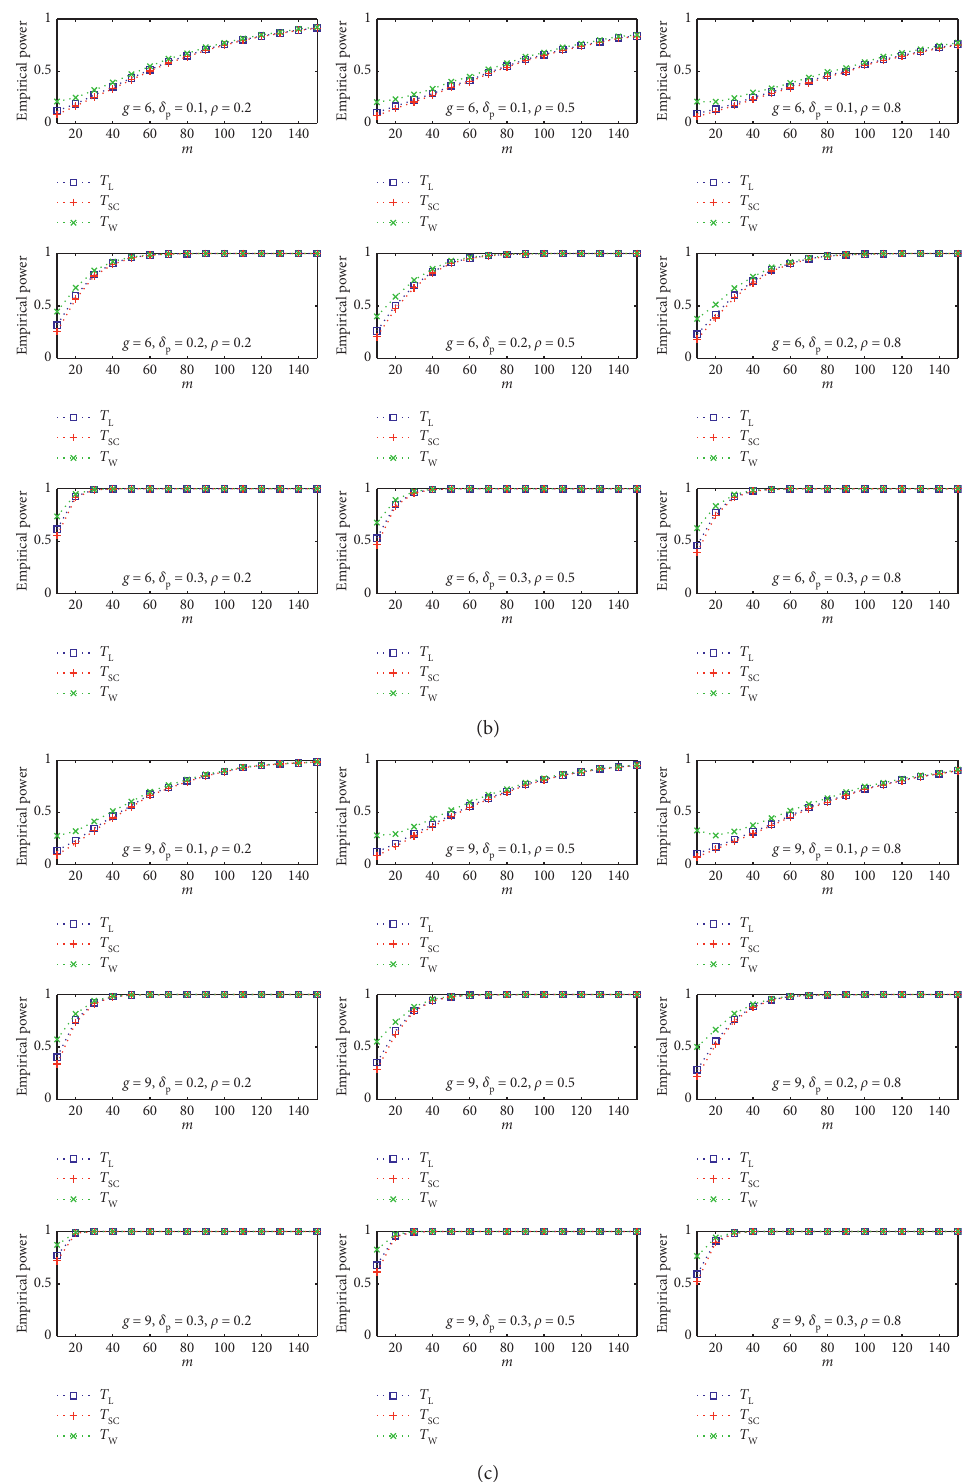
Figure 4: Empirical power of test